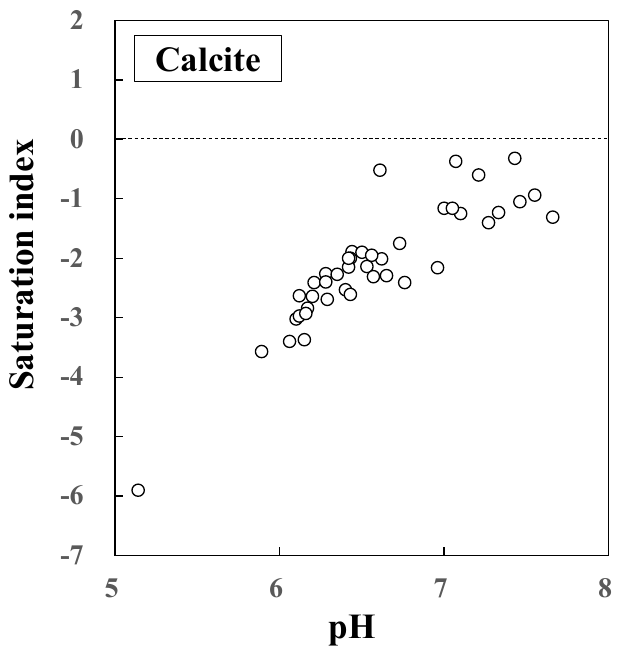
Figure 11. Saturation index of CaCO 3 (Calcite) component in the groundwater.